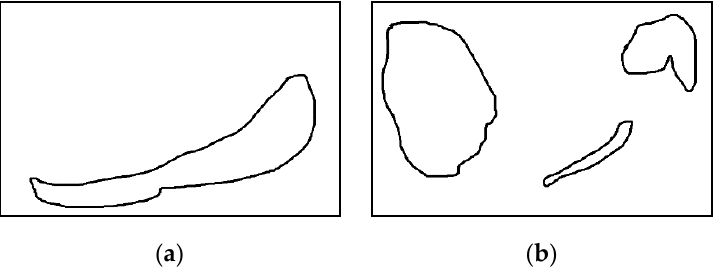
Figure 2. An example of a sketch which serves as a search query for porosity in images, when retrieving a similar object ( a ) and images with a similar distribution of porosity ( b ).